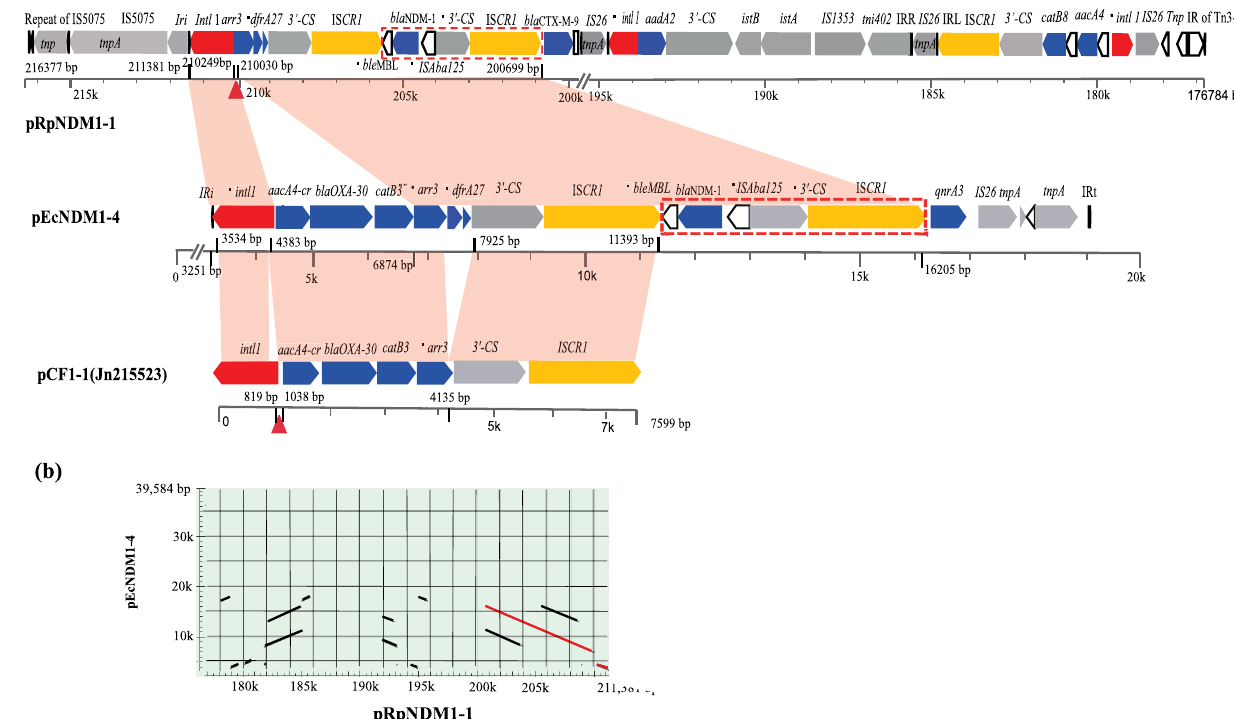
Figure 3. Schematic representation of the DNA sequences surrounding the bla NDM-1 in plasmid pEcNDM1-4, pRpNDM1-1 and homologous sequences in plasmid pCF1-1 to illustrate the relationship of the three plasmids. ( a ): Illustration of the adjacent genes of NDM-1-IS CR1 of pRpNDM1-1, pEcNDM1-4 and homologous sequences in plasmid pCF1-1. Arrows represent ORFs and their direction of transcription; Filled triangles show the same 218 bp insertion in pCF1-1 and in pRpNDM1-1, compared with pEcNDM1-4; Open rectangle represent hypothetical proteins between bla CTX-M-9 and IS26 in plasmid pRpNDM1-1; Pink shades across the plasmids indicates more than 99% identity between sequences. ( b ): MUMer-based genomic display between pEcNDM1-4 and pRpNDM1-1. The corresponding homologous sequences represented in ( a ) were highlighted in red lines.